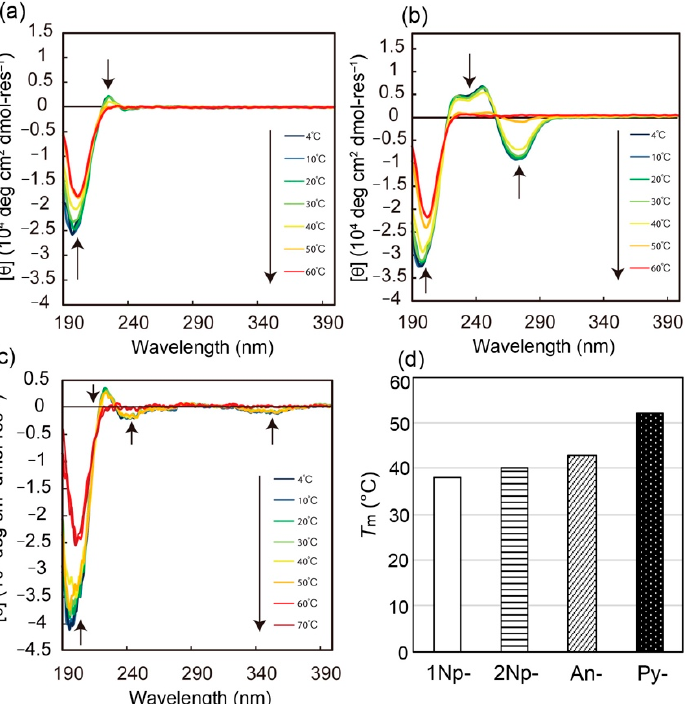
Figure 4. CD spectral changes of 1-Np-CMP 6 ( a ), An-CMP 6 ( b ) and Py-CMP 6 ( c ) in water (5% TFE) upon heating. [CMPs] = 60 μ M. ( d ) Comparison of T m for various aromatic group-terminated CMPs ( n = 6) evaluated from CD analyses.